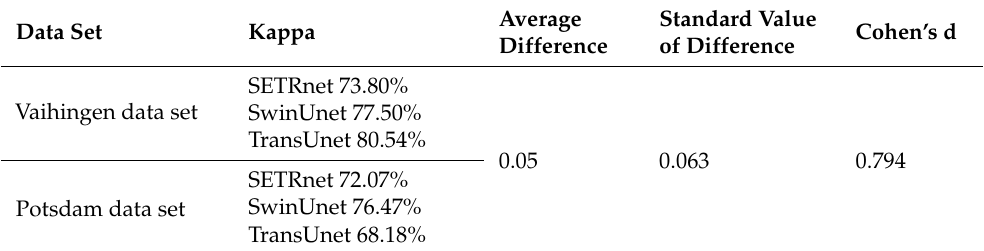
Table 5. Kappa coefficient effect scale.